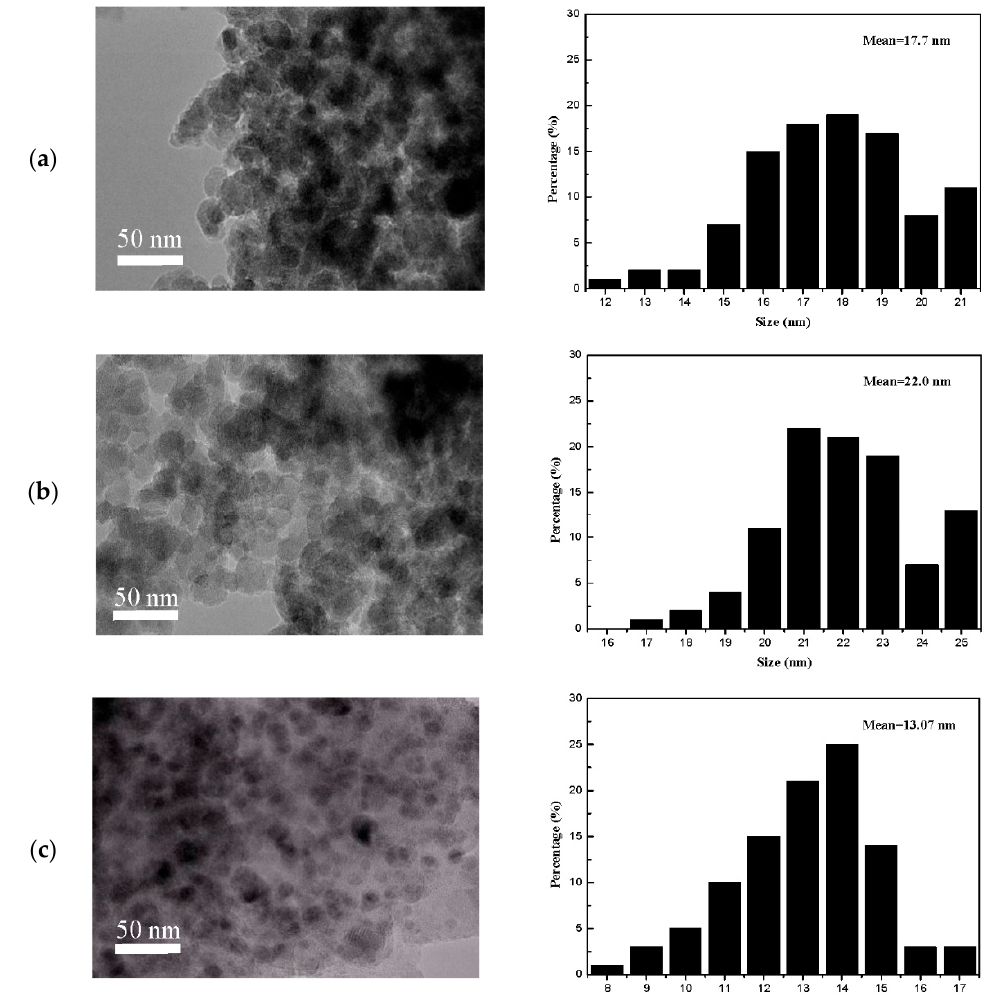
Figure 7. TEM images and particle size distributions of catalysts: ( a ) CuO / SiO 2 ; ( b ) CuO / MgO / SiO 2 ; ( c ) CuO / SiO 2